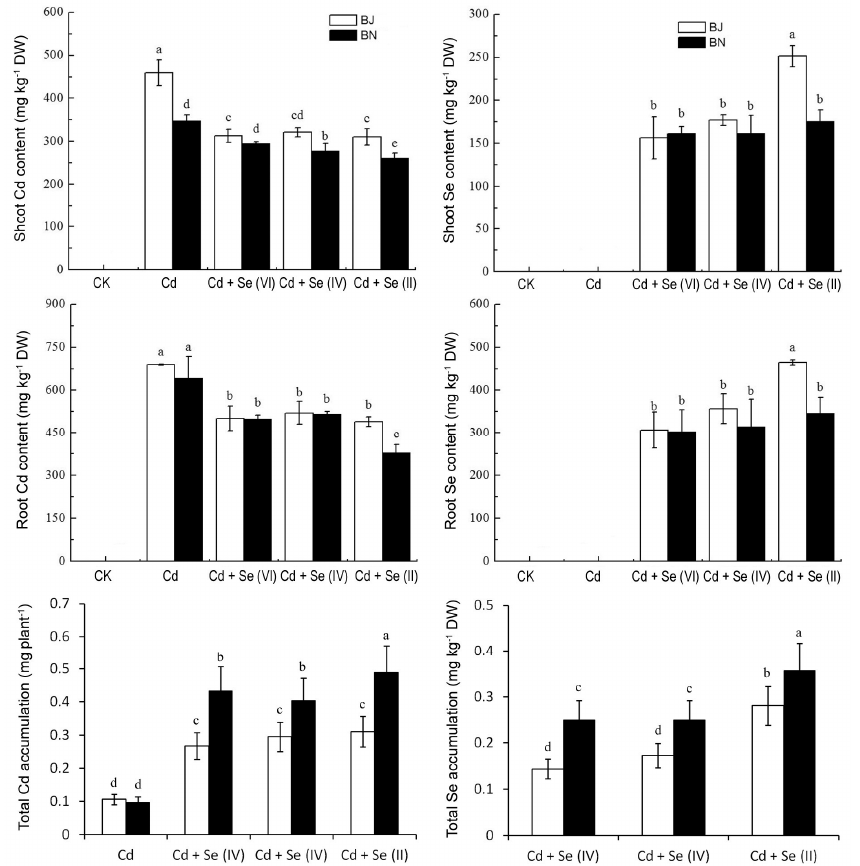
Figure 2. E ff ects of di ff erent treatments on Cd and Se content in the shoot and root of Brassica seedlings, Figure 2. Effects of different treatments on Cd and Se content in the shoot and root of Brassica DW: dry weight. All values were means ± SD ( n = 3). Di ff erent small letters indicate significant seedlings, DW: dry weight. All values were means ± SD ( n = 3). Different small letters indicate di ff erence at p < significant difference at P < 0.05.